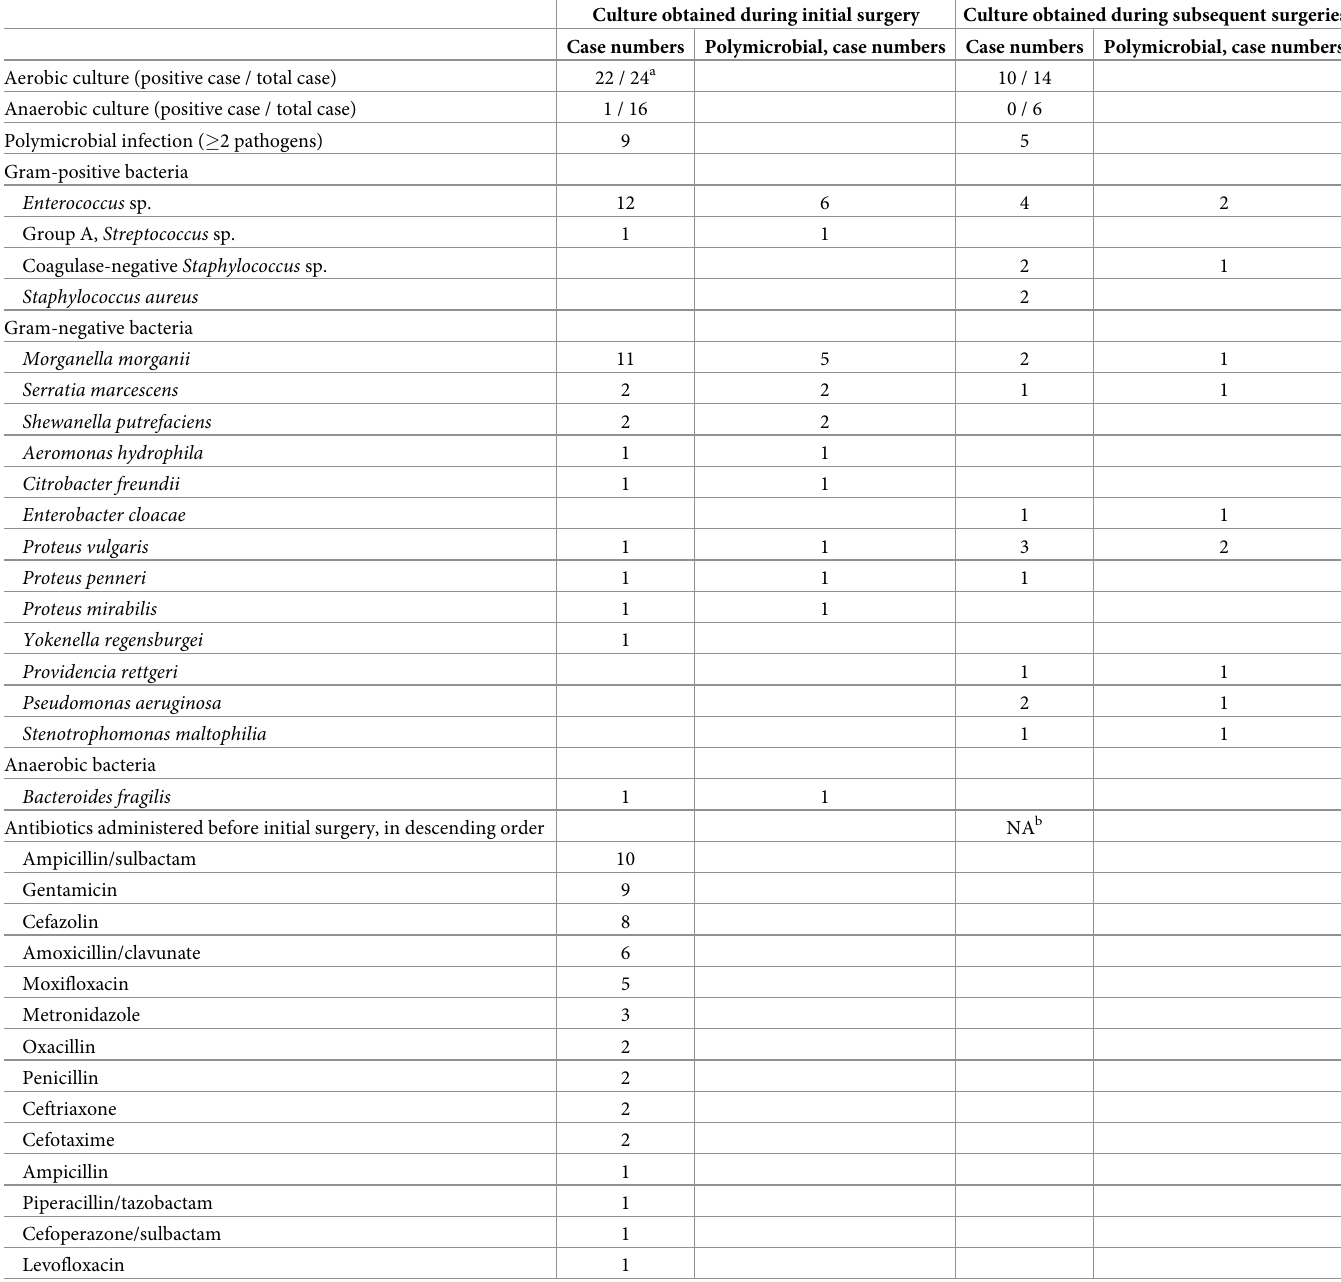
Table 2. Deep tissue cultures obtained during initial and subsequent